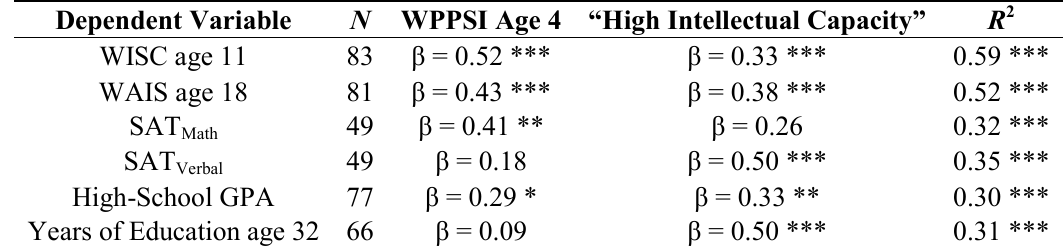
Table 3. Regression analyses predicting future intellectual ability and scholastic outcomes from age 4 IQ and “high intellectual capacity” rating as judged at ages 3–4.